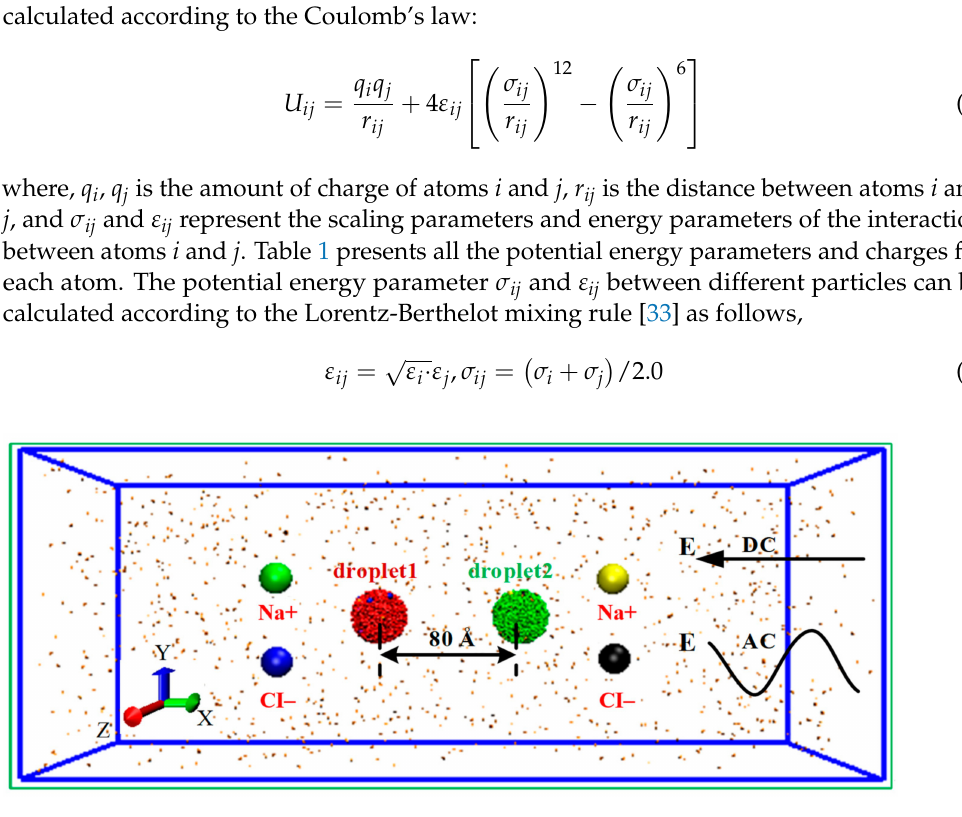
Figure 1. The initial model of the simulated system. DC and AC stands for the direct current (DC) and alternating current (AC) electric field. Table 1. Parameters of the potential function for each